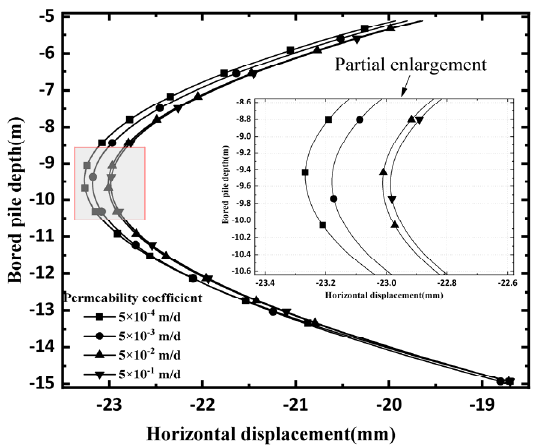
Figure 9. Horizontal displacement of different permeability coefficients with waterproof curtain.